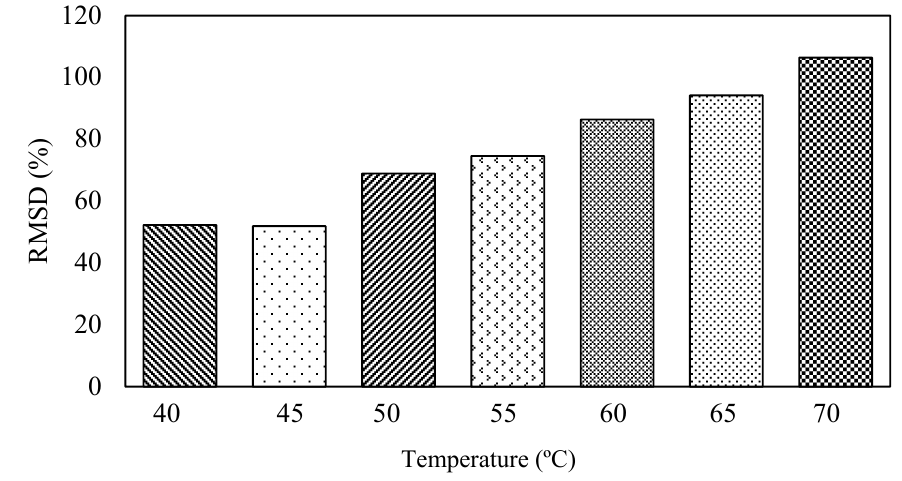
Figure 4. RMSD index at different temperature.